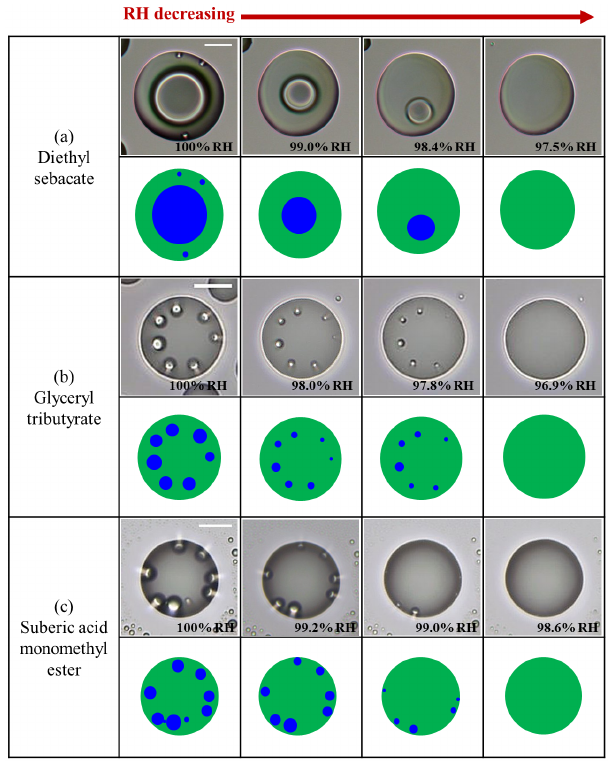
Figure 2. Optical images of single particles consisting of one or- ganic species with increasing RH: (a) diethyl sebacate particles, (b) glyceryl tributyrate particles, and (c) suberic acid monomethyl ester particles. The particles are the same ones as shown in Fig. 1 but for increasing RH. Illustrations are presented below the images. Green: organic-rich phase. Blue: water-rich phase. The scale bar is